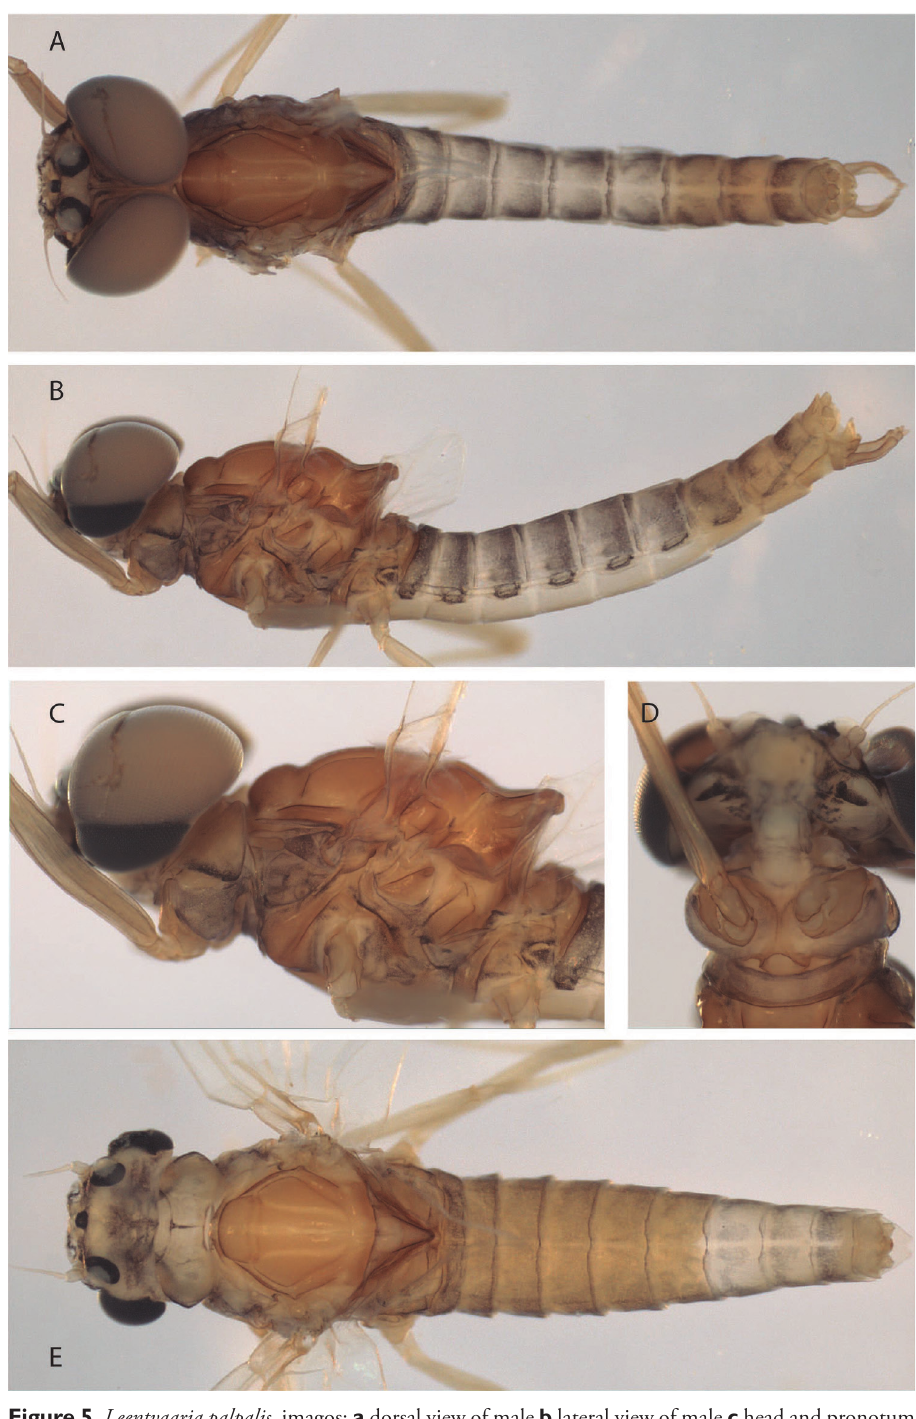
Figure 5. Leentvaaria palpalis , imagos: a dorsal view of male b lateral view of male c head and pronotum of male, lateral view d head and prosternum of male, ventral view e dorsal view of